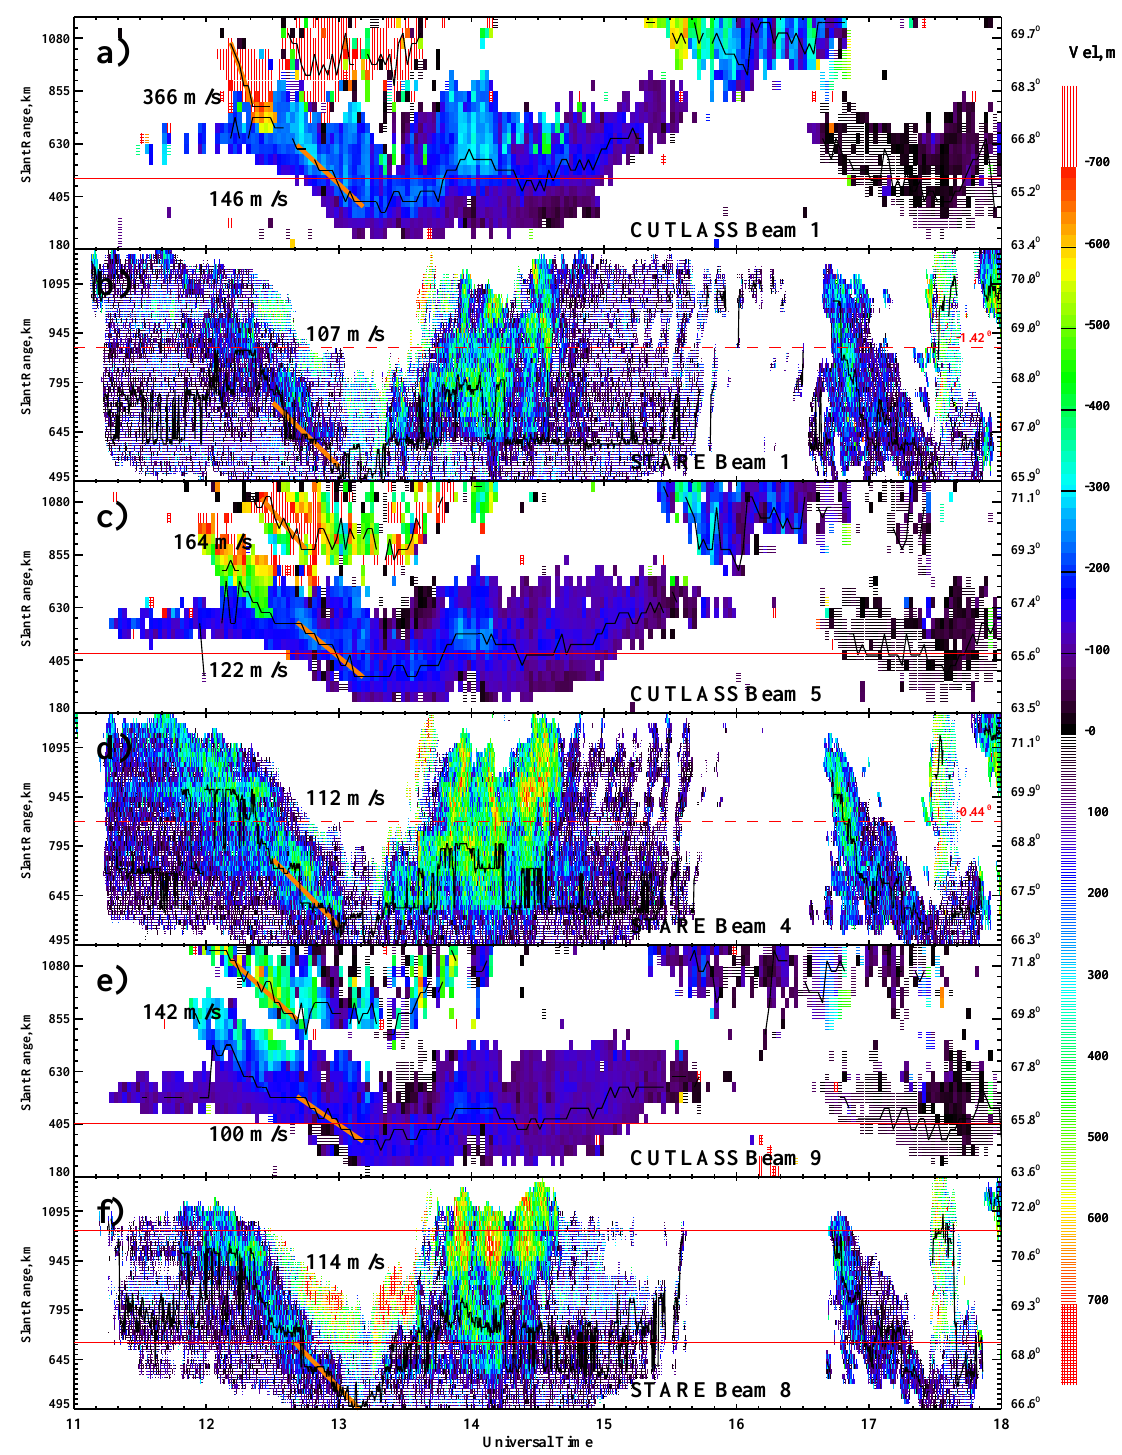
Fig. 6. The RTI plots of the Doppler velocity for various CUTLASS and STARE beams. The color scheme is indicated on the right. Cells filled with solid color (horizontal lines) correspond to the negative (positive) velocities. As in Fig. 3, the thin ragged lines show the range locations of power maxima along each radar beam, and the best linear fit to the latter is denoted by the orange straight lines. The geographic latitude along each radar beam is shown on the right axes. The red solid (dashed) horizontal lines correspond to the range location with the perfect (minimum achievable) aspect angles. The minimum achievable aspect angles for STARE beams 1 and 4 are indicated above the red dashed